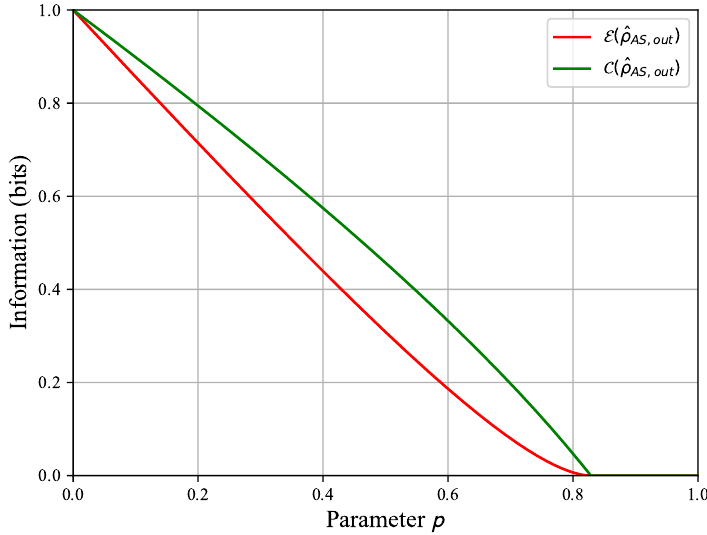
Figure 3. The concurrence of Wootters C ( ˆ ρ AS,out ) in green and the entanglement rate E ( ˆ ρ AS,out ) in red as functions of the parameter p ∈ [ 0, 1 ] for ξ = 1 / 2